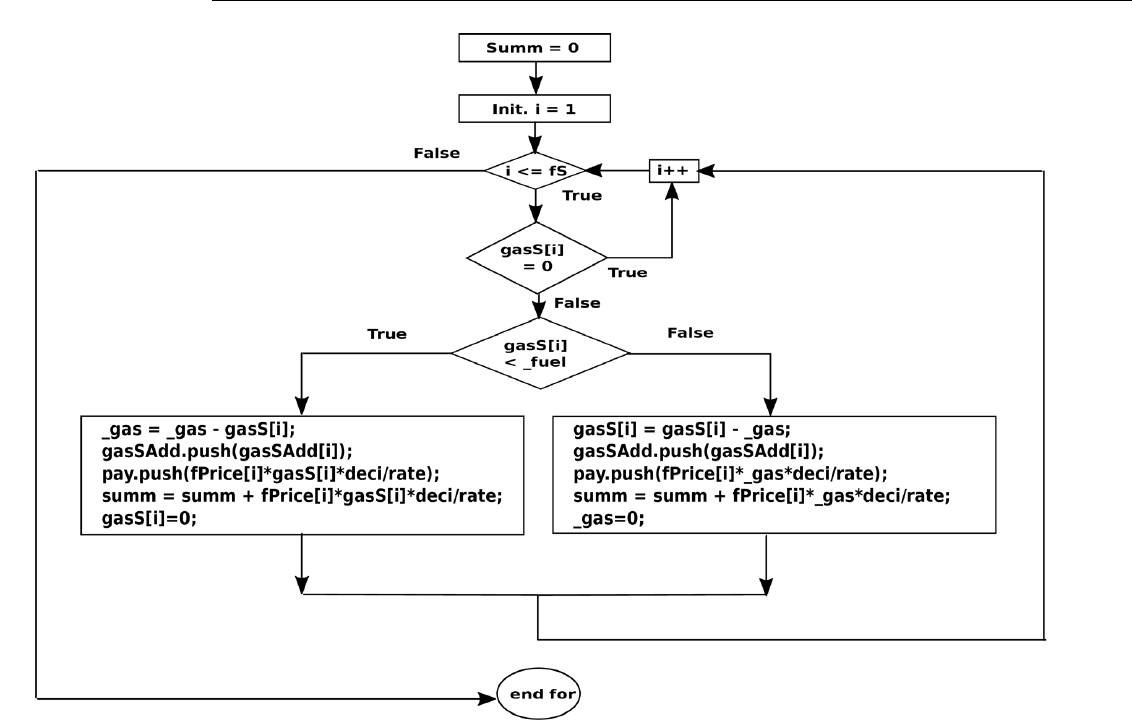
Figure 2. Flowchart for P2P gas trading scheme. Algorithm 1 Smart Contract-Based Gas Trading Scheme.